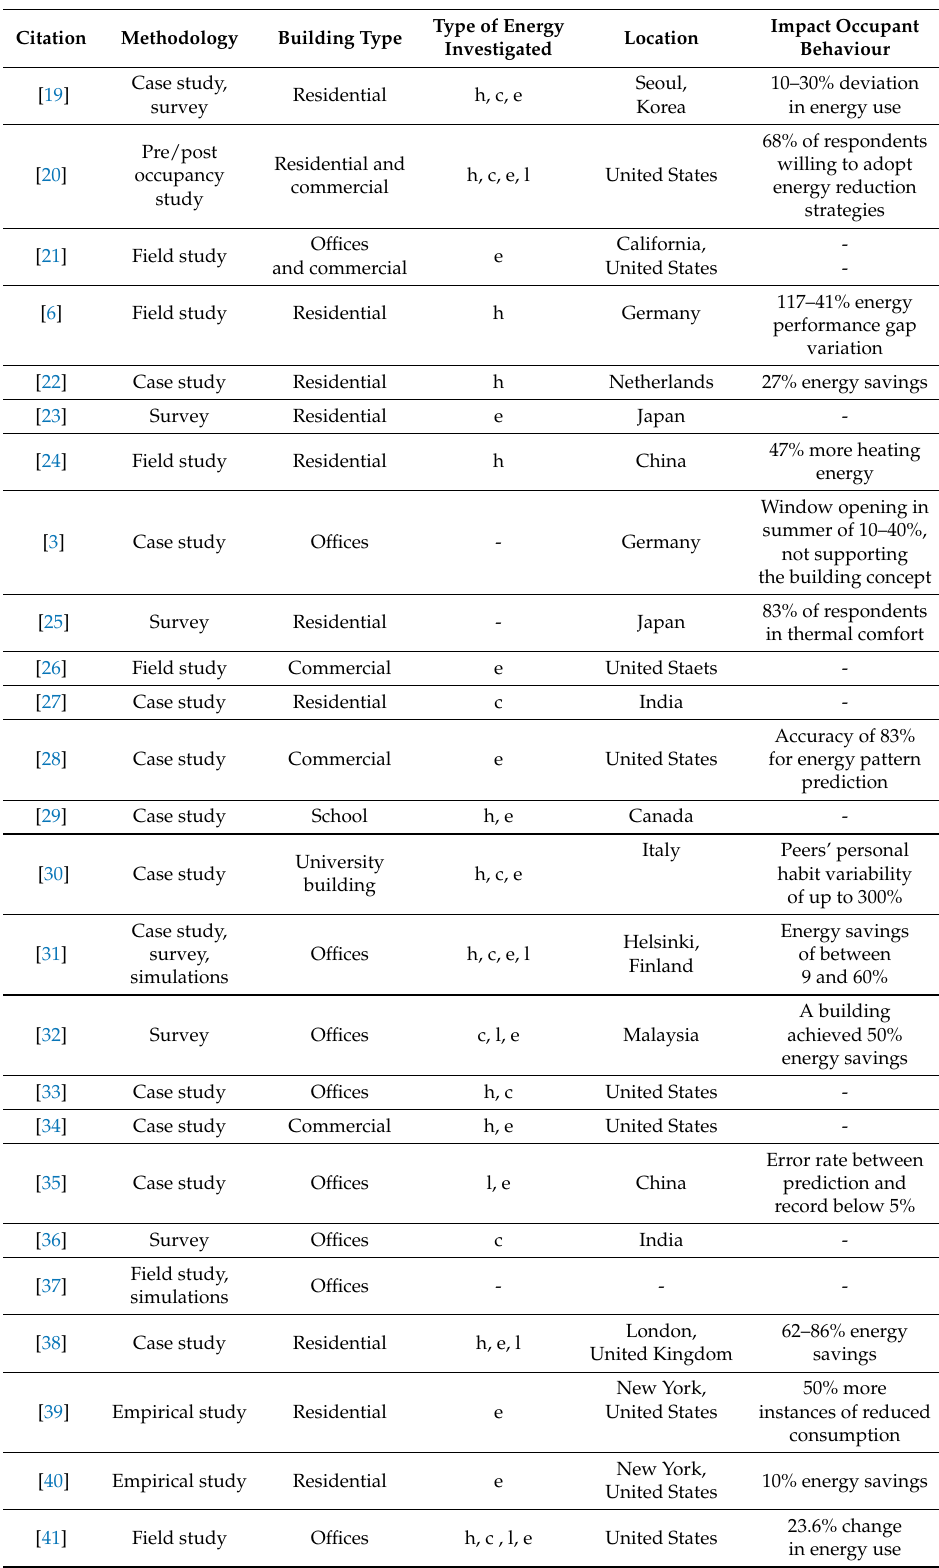
Table 1. Reviewed papers by citation, methodology, building type, type of energy investigated (heating - h -, cooling - c -, electricity - e -, lighting - l -), geographical area, and impact of occupant behavior.